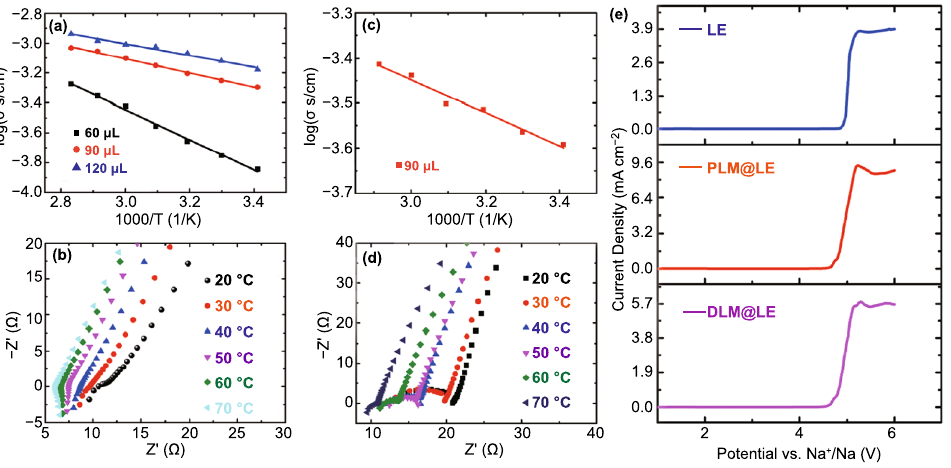
Fig. 3 a Arrhenius plots for the ionic conductivity of PLM@LE with different LE contents. b EIS of PLM@LE (0.1 g: 90 μL) at temperatures from 20 to 70 °C. c Arrhenius plot and d EIS of DLM@LE (0.1 g: 90 μL) at different temperatures. e LSV of DLM@LE, LE and PLM@LE under a scan rate of 1 mV s −1 at 23